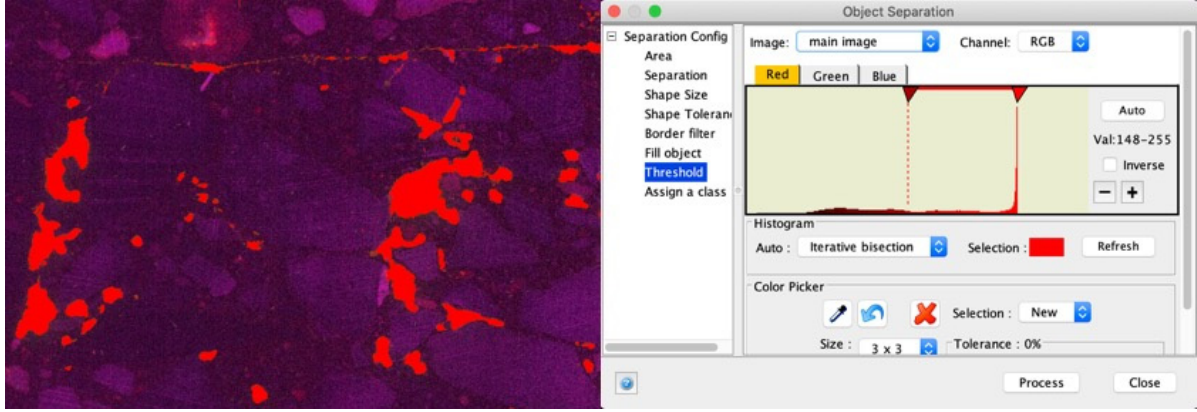
Figure 3. Identification of air voids using pixel-based segmentation. Table 1. Data types from the